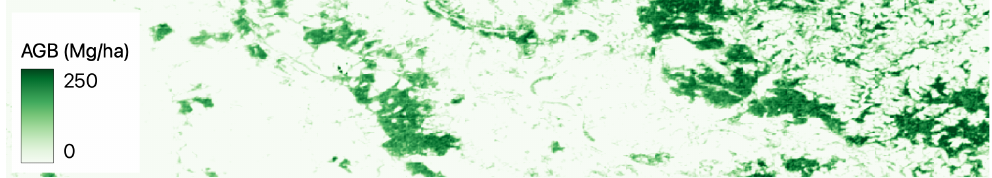
Figure 3. ReUse’s AGB predictions with raw bands in Central Europe.